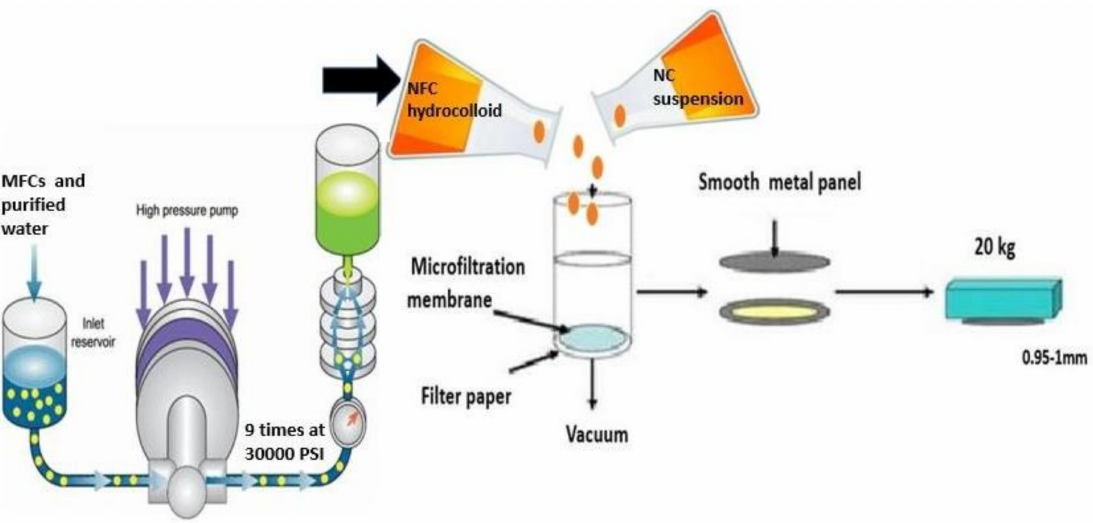
Figure 1. Process of making cellulose nanofiber / nanoclays (CNF / NC) composite